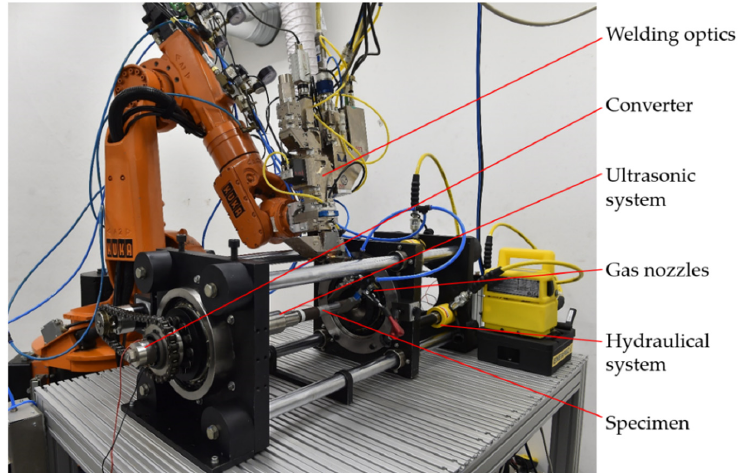
Figure 2. Experimental setup for ultrasonic assisted laser beam welding.